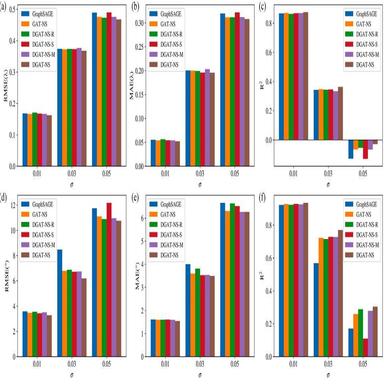
Performance comparison of different GAT variants. (a–c) and (d–f) are the results of size and angle characterisation, respectively.